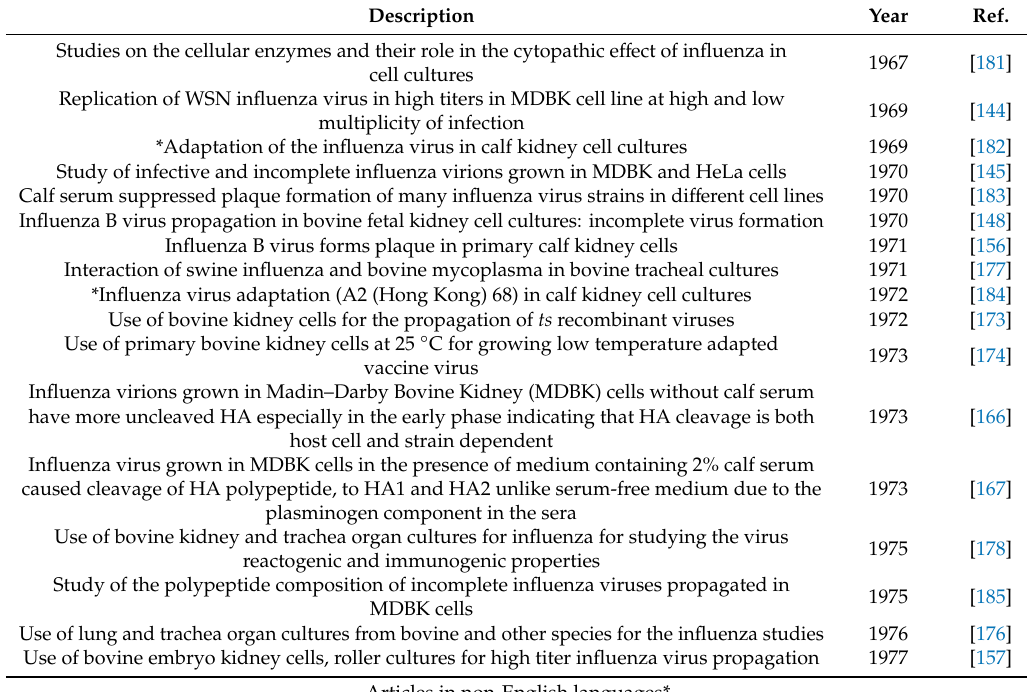
Table 3. Utility of bovine cell / tissue cultures for influenza A studies in the past.